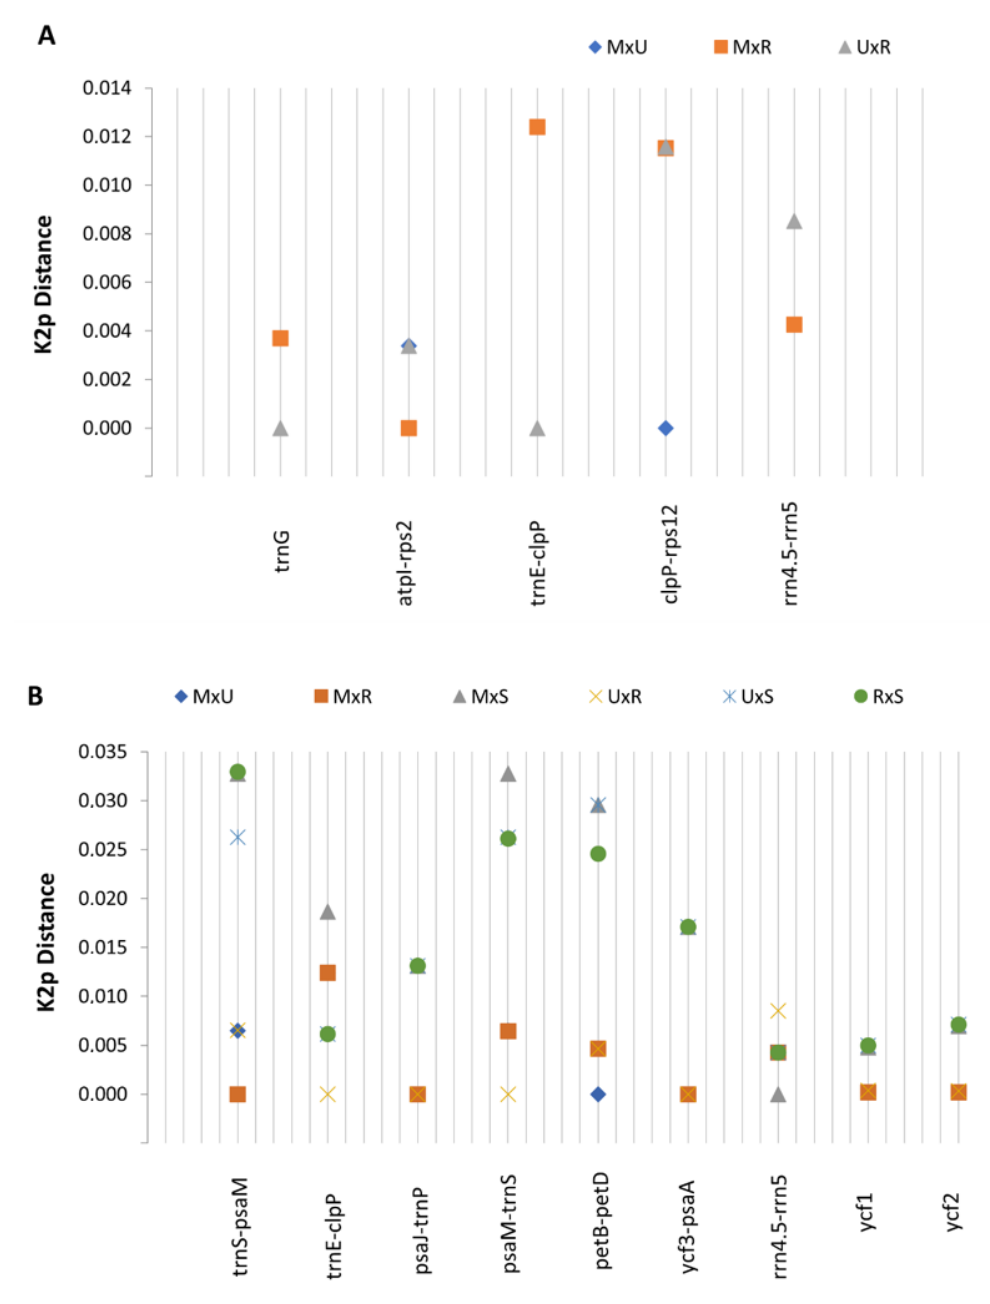
Figure 4. K2p distance for selected hotspot regions separately for the Pinus mugo complex representatives ( A ) and taxa for the Pinus mugo complex and P. sylvestris ( B ). Abbreviations: M, Pinus mugo ; R, Pinus rotundata ; U, Pinus uncinata ; S, Pinus sylvestris .